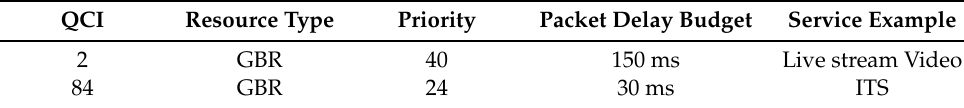
Table 1. Traffic properties